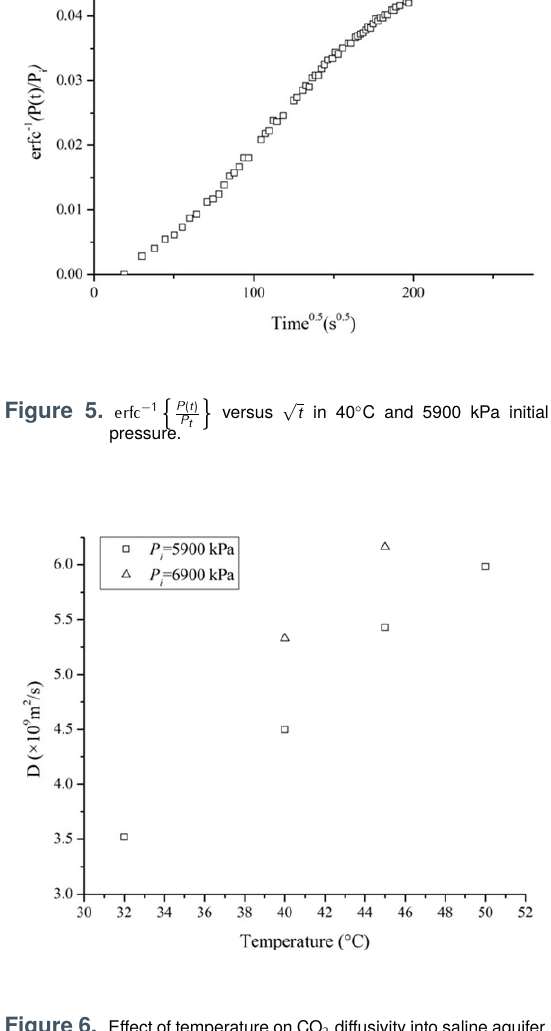
2 diffusivity into saline